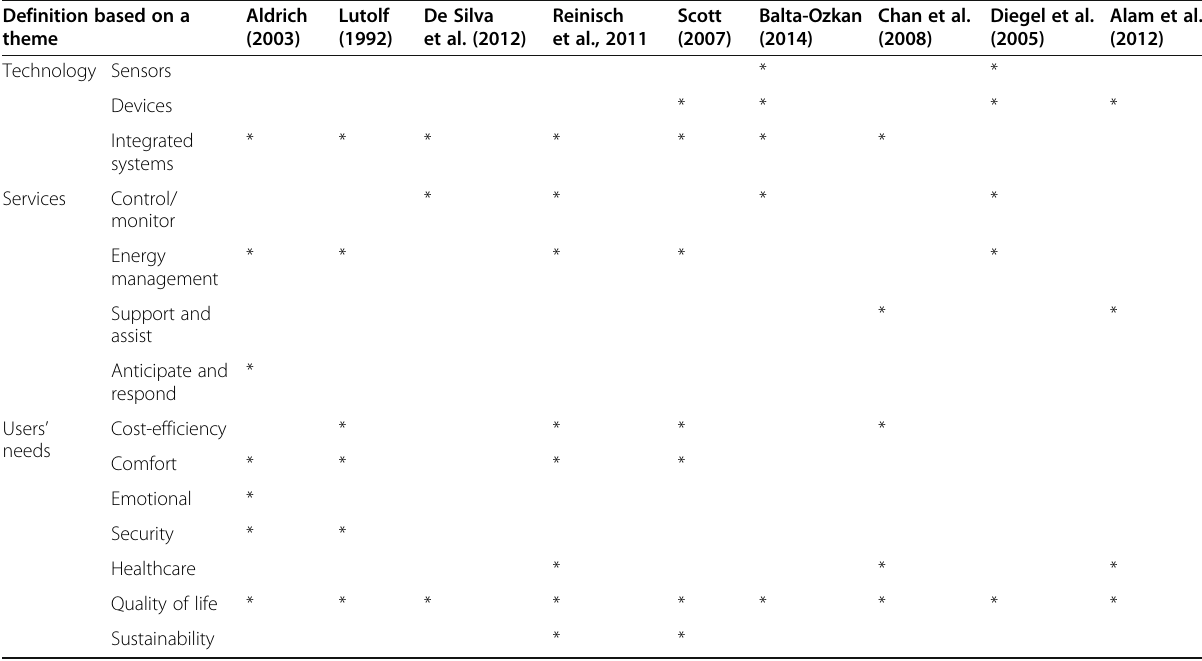
Table 3 Definitions and characteristics of smart homes [22] Definition based on a